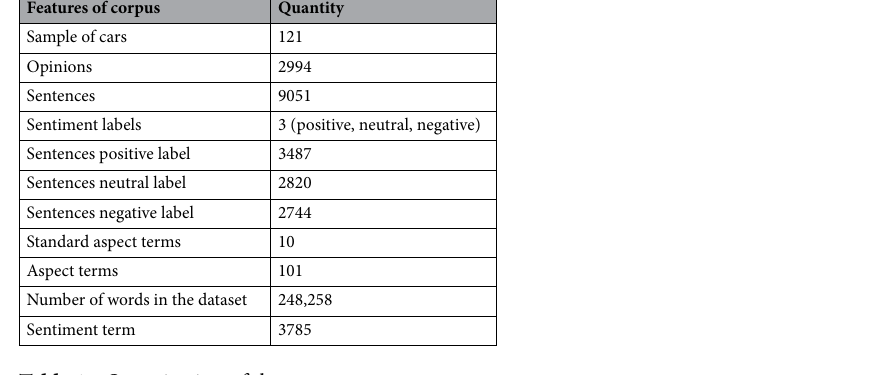
Table 1. Organization of the